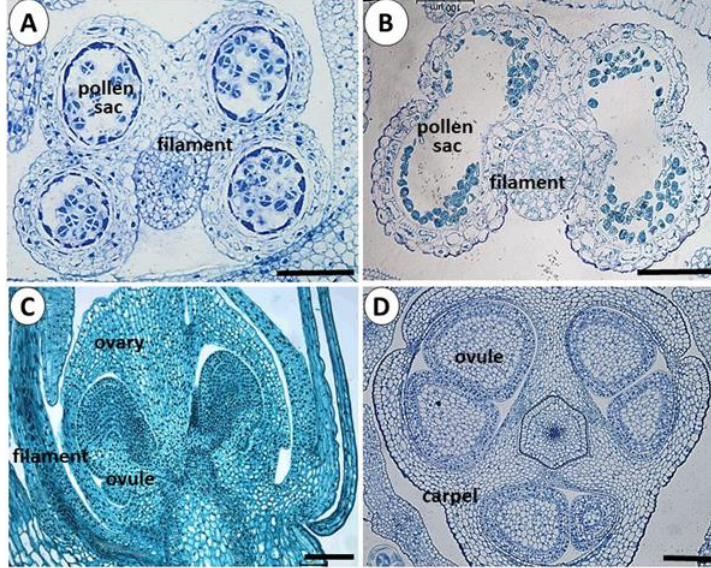
Figure 3. Structure of the garlic male and female organs. Scale = 100 µm. ( A ) Cross-section of anther during pollen meiosis. ( B ) Cross-section of anther after pollen maturation. ( C ) Longitudinal section of gynoecium during ovule development. Stamen filament is attached to the ovary basis. ( D ) Cross-section of the developing ovary.